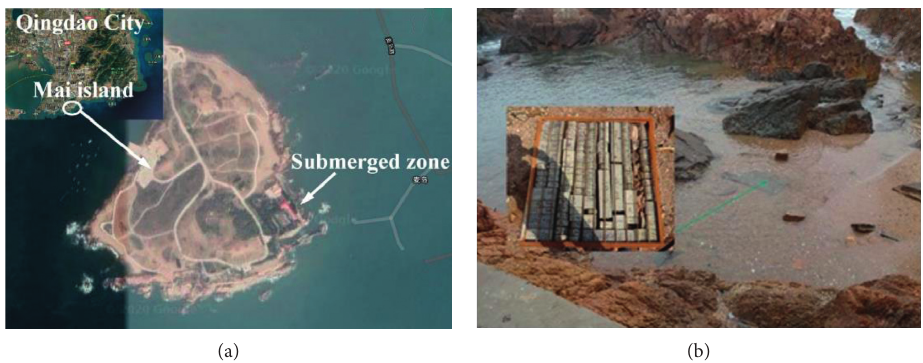
Figure 2: Experimental diagrams. (a) Geographic position of Mai Island. (b) Diagram of specimens.